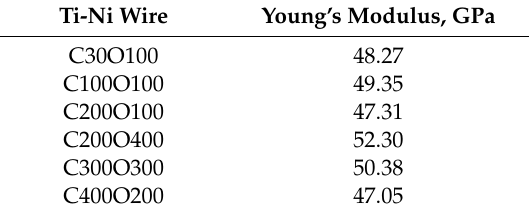
Figure 7. SEM-SE images of a pair of fracture surfaces of C300O300 wire after fatigue test. ( a ) Fracture surface containing Ti4Ni2O x inclusion acted as crack initiation site. ( b ) Counter part of fracture surface containing void corresponding to the trace of inclusion in ( a ). Table 3. Energy-dispersive X-ray spectroscopy (EDS) analysis of nonmetallic inclusions at the crack origins in a fatigue fracture surface of C300O300 wire. Element